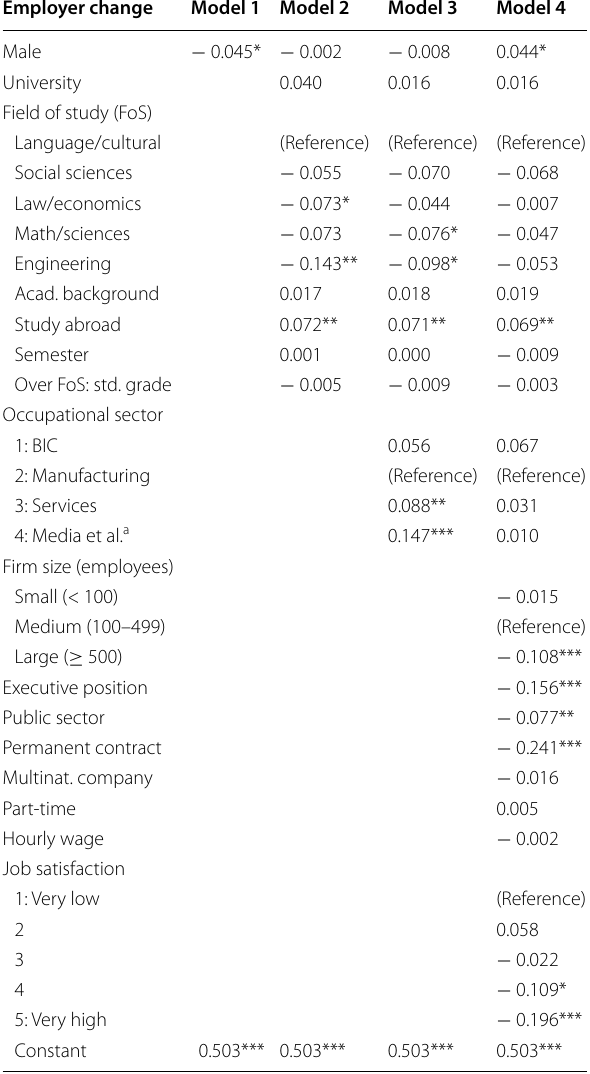
N 2258; χ 2 : p 0.000; Cramér’s V: 0.109 = = Table 5 Average marginal effects for logistic regressions on employer change. Source BAP 2005/06, author’s calcu-